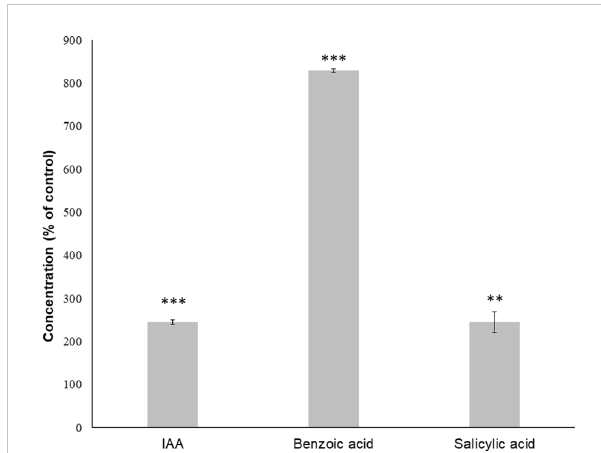
FIGURE 7 Relative concentration of Arabidopsis plant hormones identi fi ed through GC-MS after 14 days of treatment with the IC 50 of TC. Asterisks indicate signi fi cant differences compared to the control: ** ( p ≤ 0.01), *** ( p ≤ 0.001); data were analysed through t-test with p ≤ 0.05. Bars indicate standard deviation.